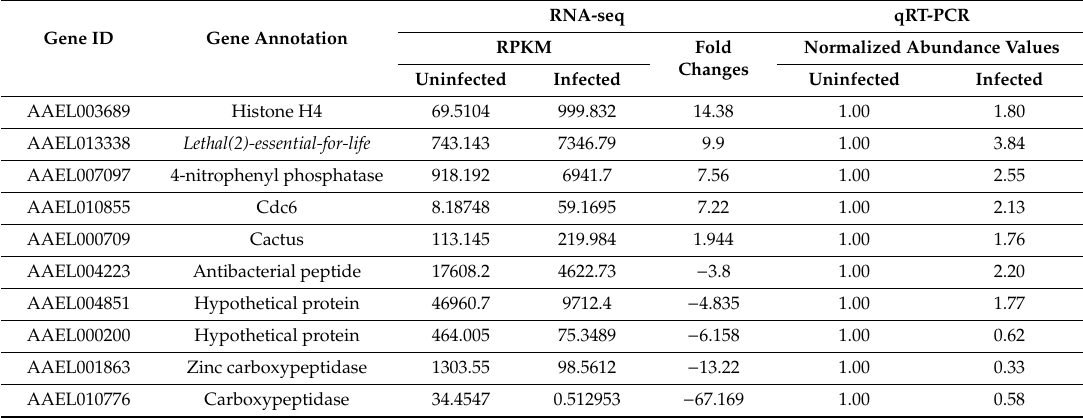
Table 2. Real-time PCR was used to validate the RNA-seq data. We randomly selected 10 genes and confirmed their expression in a pool of 10 mosquitoes. The RNA-seq and qRT-PCR data were obtained from two di ff erent mosquito populations. Compared to the RNA-seq data, the qRT-PCR data does not show large discrepancies in the abundances. The RNA-seq and qRT-PCR data are correlated statistically with a Spearman Rho’s R of 0.79394 ( p < 0.01) between the two assays. qRT-PCR values are the average of two biological